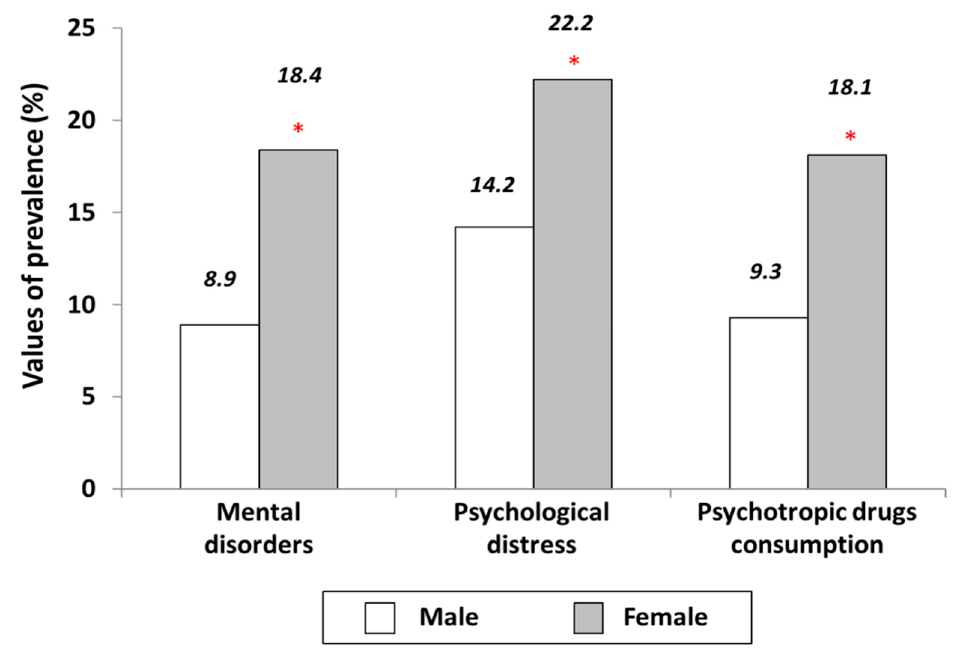
Figure 1. Prevalence of variables of mental disorders, psychological distress and psychotropic drug consumption according to gender. * p value < 0.001 for the comparison between men and women.